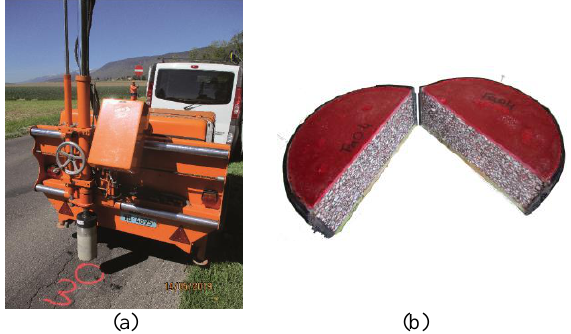
Figure 1: (a) coring machine (b) core impregnated with fluorescent epoxy